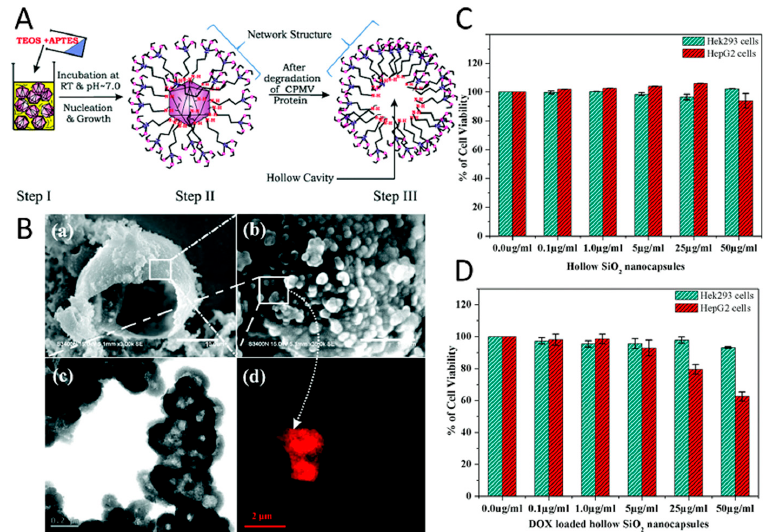
Figure 4. ( A ) Schematic representing the proposed synthesis mechanism of the